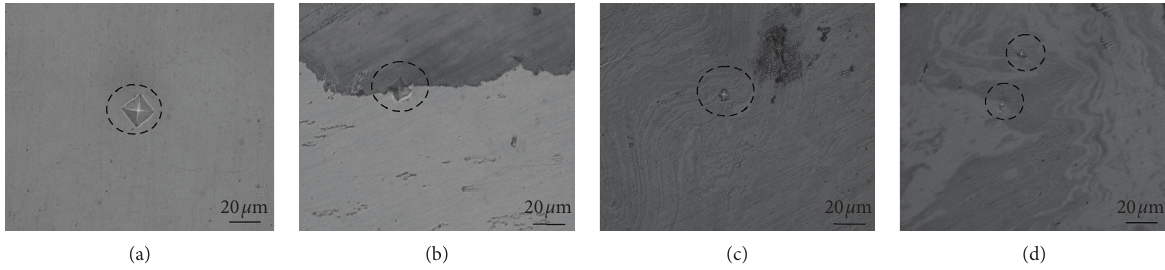
Figure 10: Microhardness indentation: (a) base material area; (b) Al-Cu interface; (c) (d) Al-Cu layered mixed area.